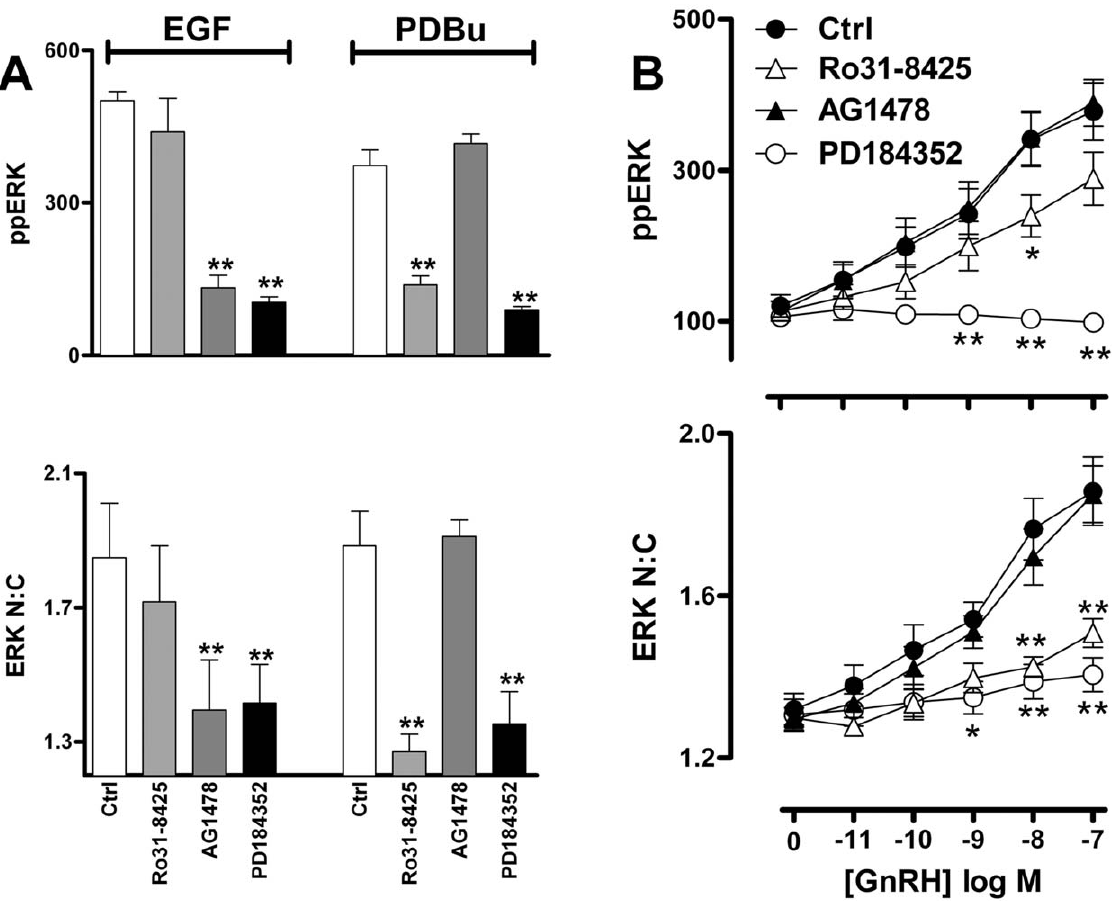
Figure 5. GnRH-induced ERK phosphorylation and nuclear localization is partially dependent on PKC activation. Cells were treated, imaged and analysed as described for fig. 2, except that the stimulation was for 10 min with 1 m M PDBu or 10 nM EGF in cells that had been pre- treated for 10 min with DMSO vehicle (Ctrl), 200 nM Ro31-8425 PKC inhibitor, 100 nM AG1478 EGFR inhibitor or 10 m M PD184352 MEK inhibitor (panel A), or the cells were stimulated for 5 min with the indicated concentrations of GnRH in the presence of the same inhibitors (panel B). Panel A show population average values for ppERK in AFU (top panel) and ERK N:C (bottom panel) after treatment with inhibitors and agonists as indicated. Data are shown are mean 6 SEM (n=3), **=p , 0.01, comparing Ctrl and inhibitor co-incubations for each readout, according to one-way ANOVA and Dunnet’s post-hoc test. Panel B shows concentration-response curves for the effect of GnRH on population averaged ppERK intensity (in AFU) and ERK N:C responses. Data are shown means 6 SEM (n=6) and two way ANOVAs revealed GnRH, Ro31-8425 and PD184352 as significant sources of variation (P , 0.01) for both measures (ppERK and ERK N:C), whereas AG1478 was not a significant variable for either (P . 0.05). *P , 0.05, **P , 0.01 comparing with and without inhibitor at matched GnRH